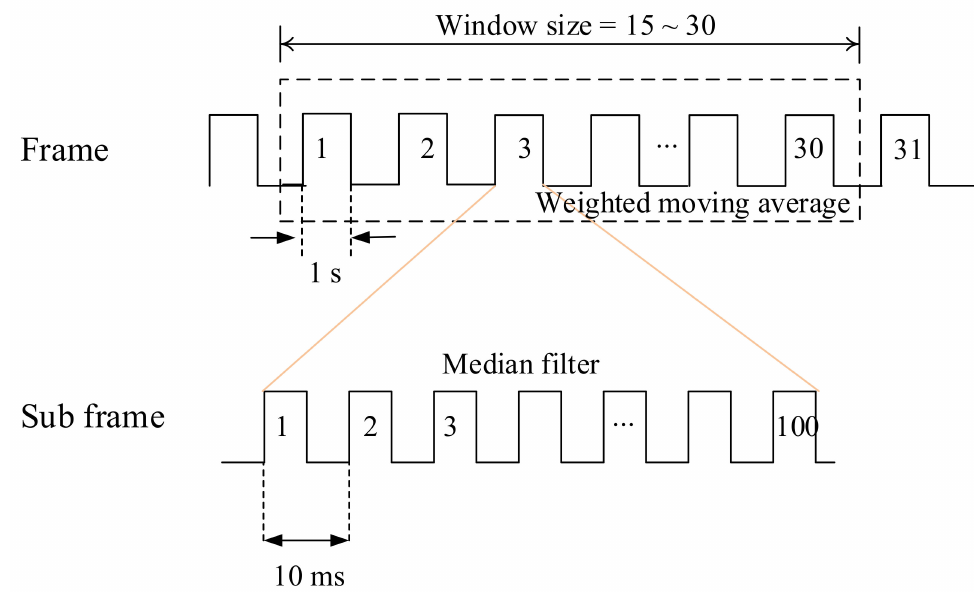
Figure 5. Sensing frame and sub